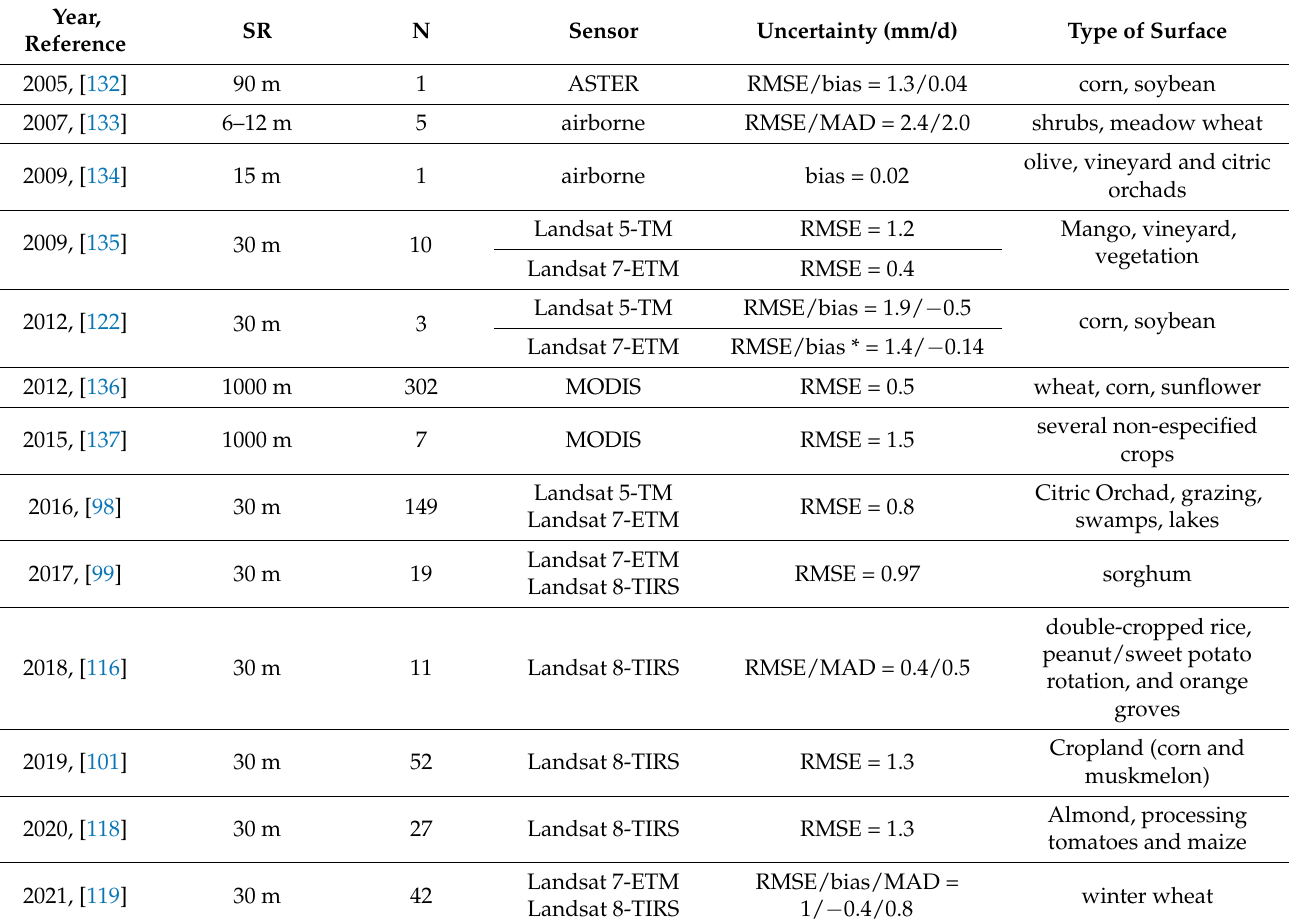
Table 3. Representative chronological compendium of validation studies of the SEBAL